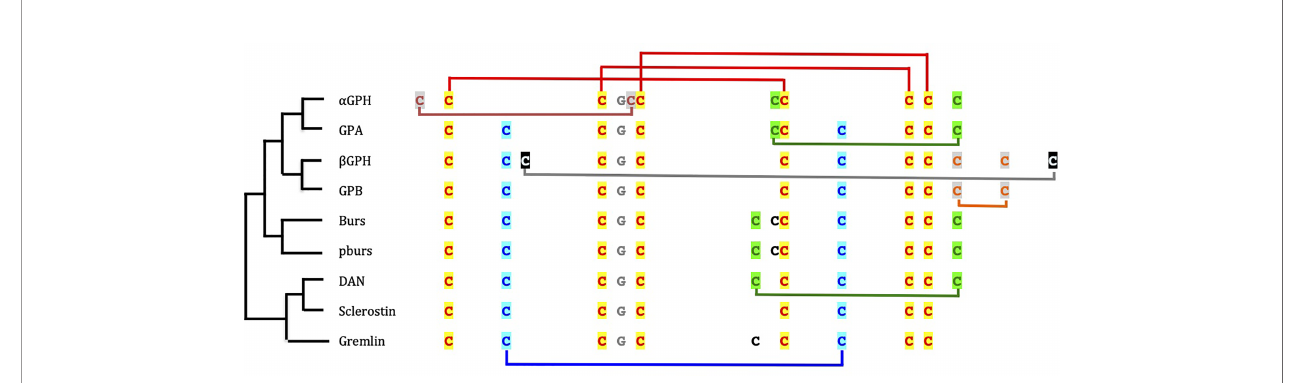
FIGURE 2 | Cysteine residue arrangement of glycoprotein hormone (GPH) subunits and cystine-knot growth factors. The phylogenetic relationships [after (67)] between sequence types are schematically represented on the left side. Disul fi de bridges between cysteine residues involved in the cystine-knot are depicted in red on top of the sequences. The other cysteine residues linked by disul fi de bridges are given in different colors according to their position in the folded protein. The cysteine residues in black are not involved in intramolecular bridge. The glycine residue conserved in all cystine-knot growth factor is indicated in grey. GPA and GPB are the precursor forms in invertebrates of GPH a - and GPH b subunits, respectively; Burs is for bursicon a and pburs for bursicon b ; DAN is for differential screening-selected gene aberrant in